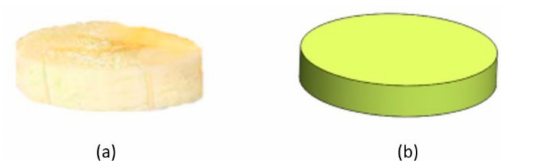
Figure 2. The geometrical model.